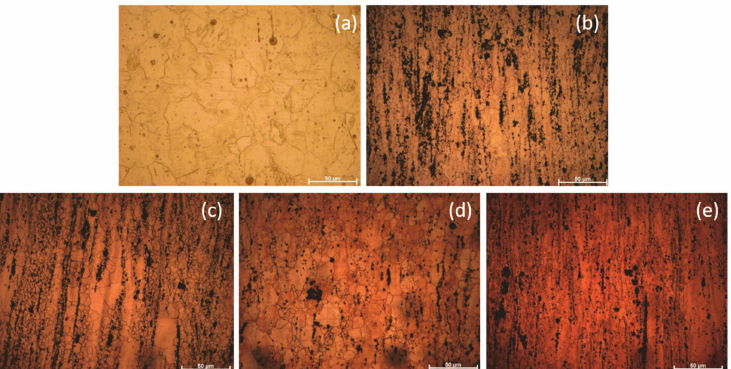
Figure 2. Optical microstructures of ( a ) Pure Mg ( b ) Mg-5Sn ( c ) Mg-5Sn-0.5Y ( d ) Mg-5Sn-1Y and ( e ) Mg-5Sn-2Y. Table 2. Hardness and grain size values for pure Mg and Mg-5Sn-xY (x = 0, 0.5, 1 and 2 wt.%) alloys.